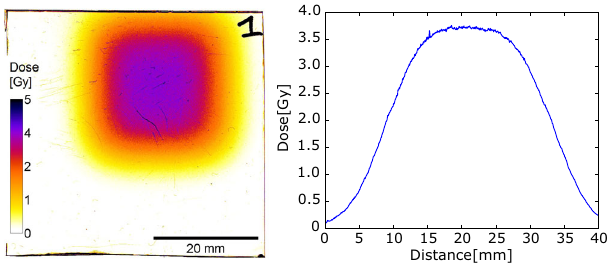
FIG. 6. Dose deposition profile of the CPO proton beam recorded on a stack of RCF EBT2 placed behind the collimator. The graph on the right shows an averaged horizontal lineout of the dose